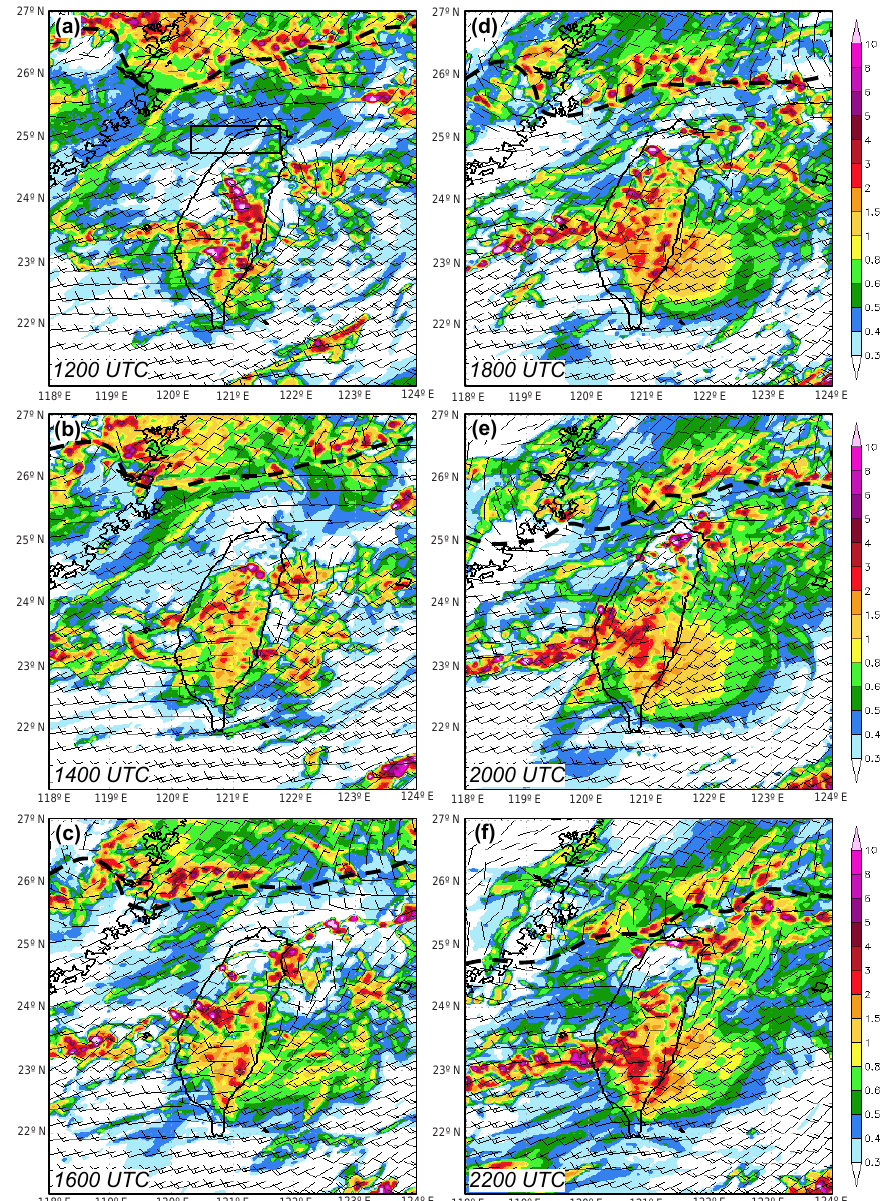
Figure 7. CReSS simulation of surface winds at 10m height (ms − 1 ) and column-maximum mixing ratio of precipitation (rain + snow + graupel, gkg − 1 , shading, scale to the right) every 2h from (a) 12:00UTC to (f) 22:00UTC on 11 June 2012. For winds, full (half) barbs denote 10 (5)ms − 1 , and the surface frontal positions are marked (thick dashed lines). The rectangle in panel (a) depicts the